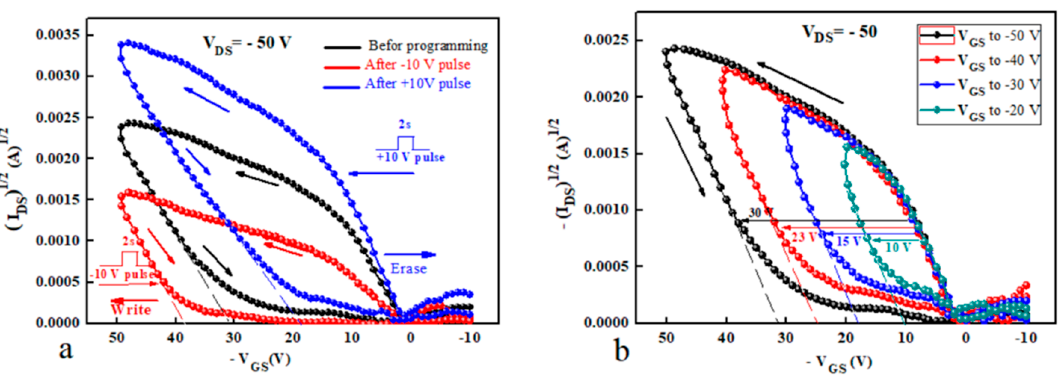
Figure 5. ( a ) Transfer characteristics of the fabricated OTFMT after the application of positive and negative pulses of 10 V for 2 s. ( b ) Double sweep of transfer characteristics of OTFMT with different maximin gate voltages.